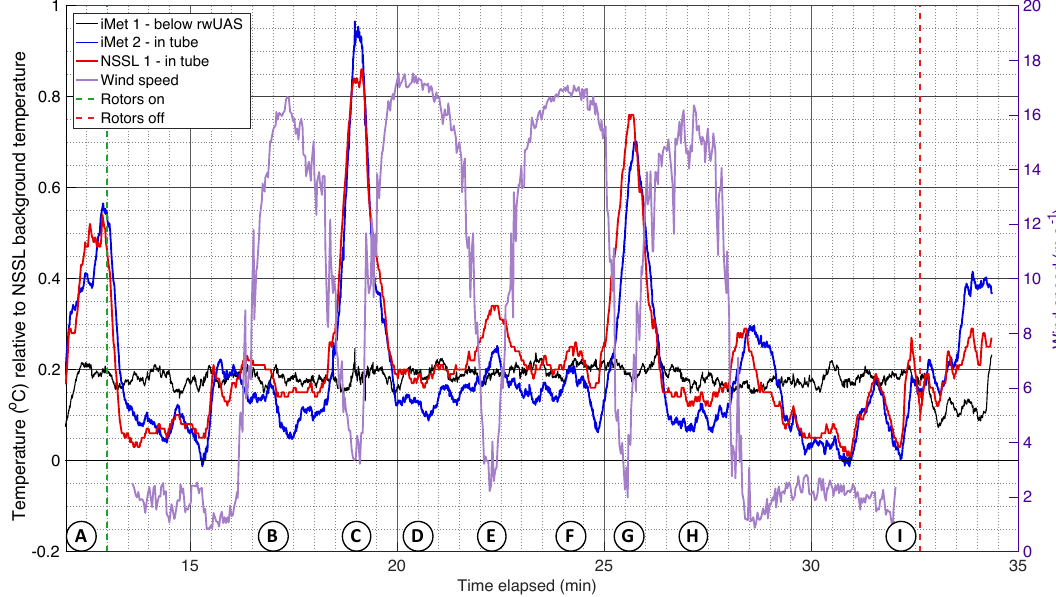
Figure 7. Experiment 1 time series of temperature ( ◦ C) relative to the NSSL background temperature after the actuator arm begins incre- menting. Points A–I are included from Fig. 2.